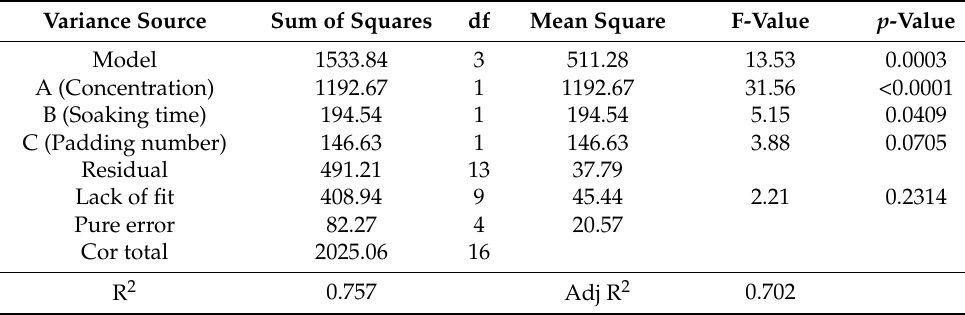
Table 3. ANOVA results for felt ball